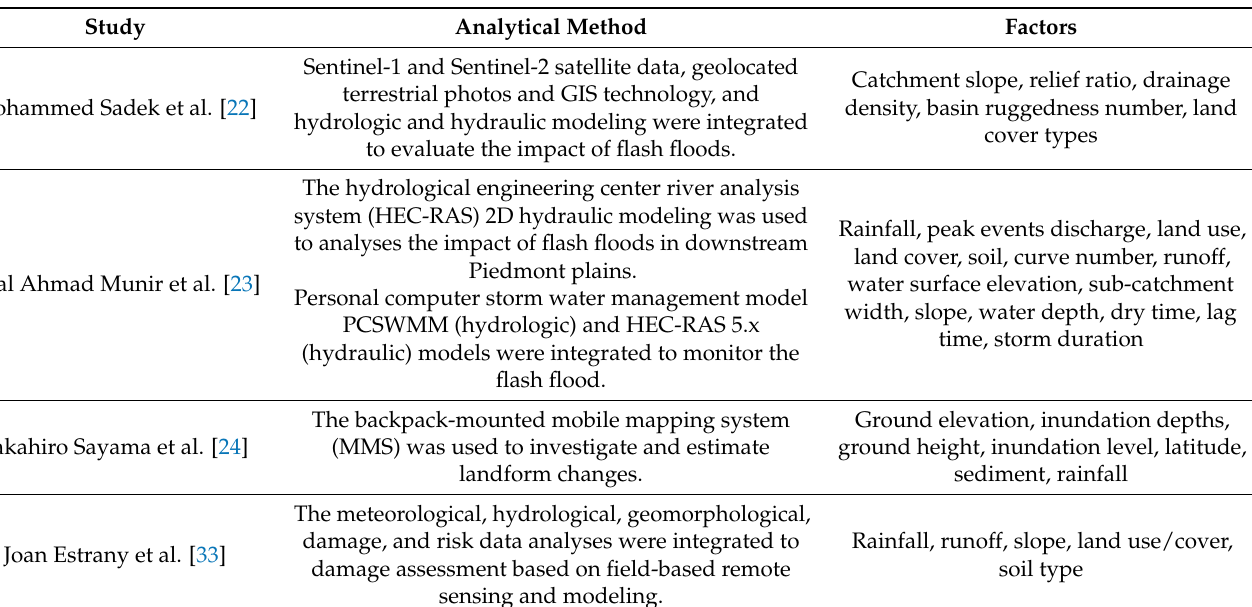
Table 3. For impact of flash